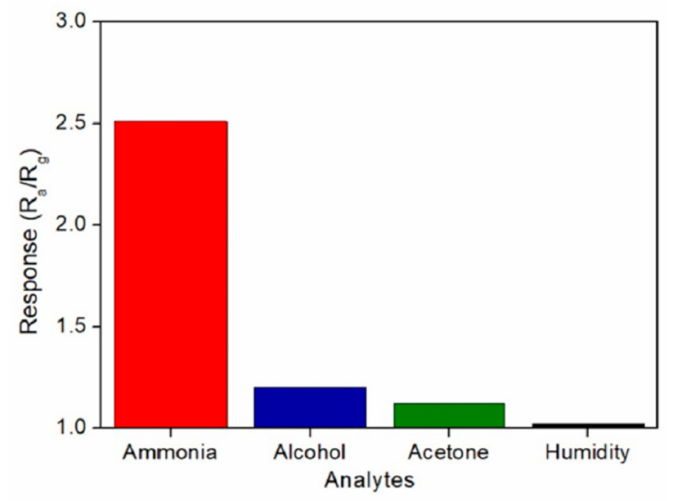
Figure 14. Selectivity of the synthesized sensor towards various test gases. Reprinted from Ref. [161] with permission of Elsevier Ltd.,